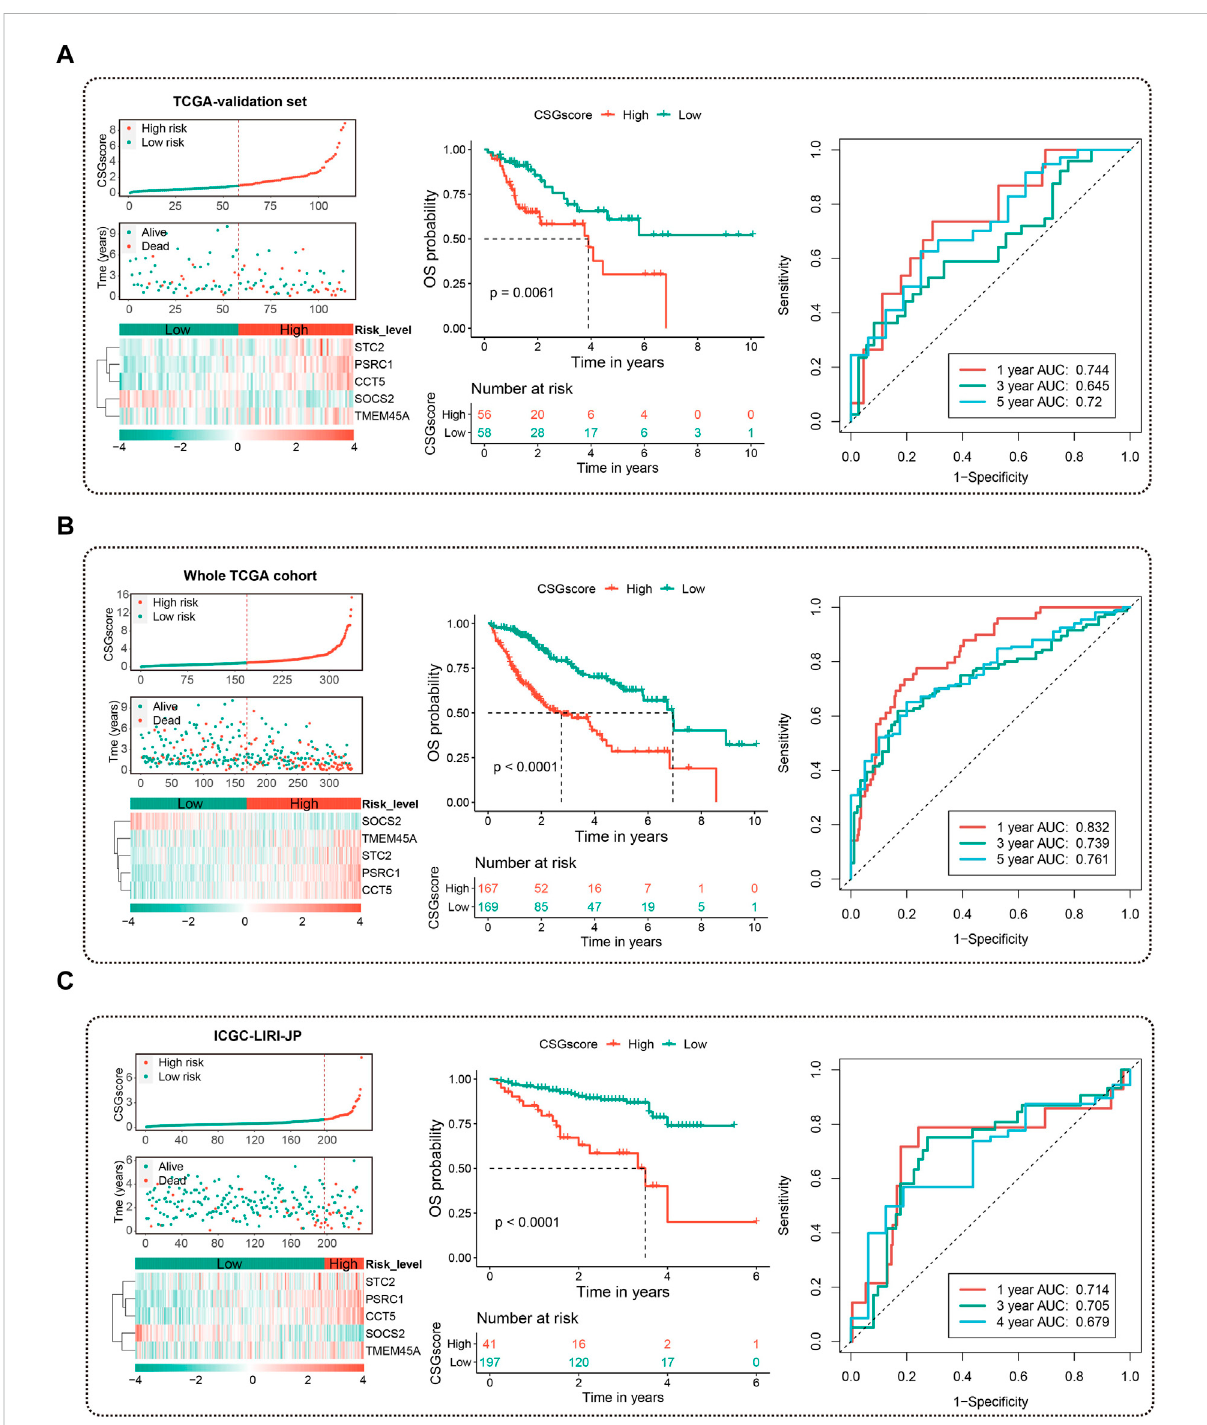
FIGURE 6 Validation of the prognostic value of CSGscore in HCC. (A – C) The left panels indicate the distribution of CSGscore, survival status, and the expression of the fi ve CSGscore genes in the TCGA validation set (A) , the whole TCGA cohort (B) , and the ICGC-LIRI-JP dataset (C) . The middle and rightpanelsindicatetheKaplan-Meiersurvivalplots(themiddlepanels)andthetROC(therightpanels)ofCSGscorefortheOSoftheTCGAvalidation set (A) , the whole TCGA cohort (B) , and the ICGC-LIRI-JP dataset (C) .